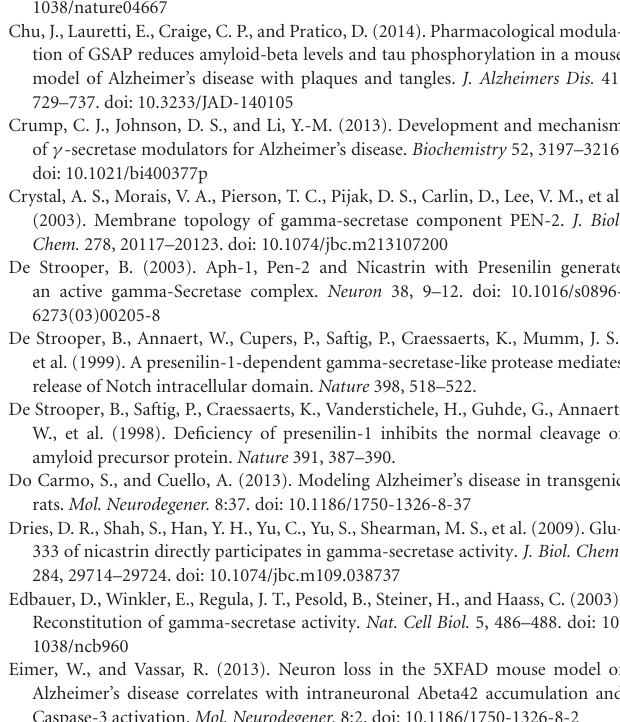
FIGURE 4 | Substrate-based regulation of γ -Secretase . α or β -secretase cleave amyloid precursor protein to generate α CTF or β CTF, respectively. α CTF and β CTF, which are γ -secretase substrates, can then interact with γ -secretase to form a substrate-enzyme complex. The substrate inhibitory domain (ASID) in α CTF and β CTF interacts with γ -secretase in a location distinct from both the active site and the substrate binding site of the enzyme. Binding of α CTF to γ -secretase results in a low-productivity complex: the ASID in α CTF inhibits γ -secretase activity for A β production. ASID in β CTF is a less potent inhibitor of γ -secretase. The implication is that α -secretase cleavage potentiates γ -secretase inhibition by at least two mechanisms: first, α -secretase cleaves APP in the middle of the A β region, precluding A β formation, and second, α -secretase cleavage results in formation of α CTF, which inhibits γ -secretase activity through its ASID. γ -Secretase cleavage of α CTF produces p3 and cleavage of β CTF produces the amyloidogenic A β